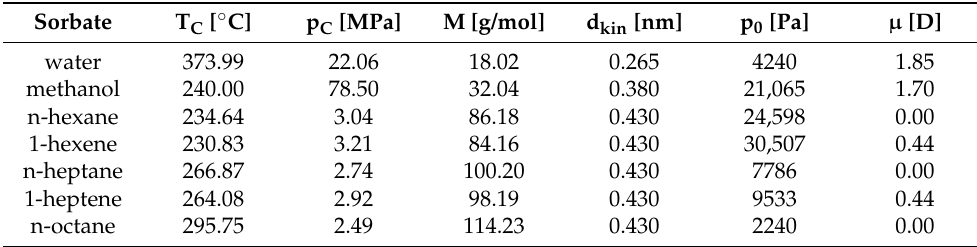
Table 2. Characteristic of sorbates.